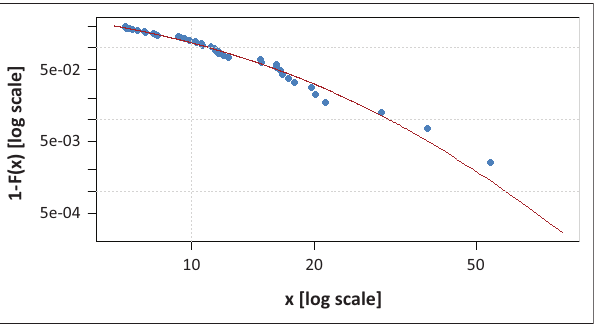
FIGURE 18: Diagnostic plot for peak over threshold analysis: Tail of the underlying distribution